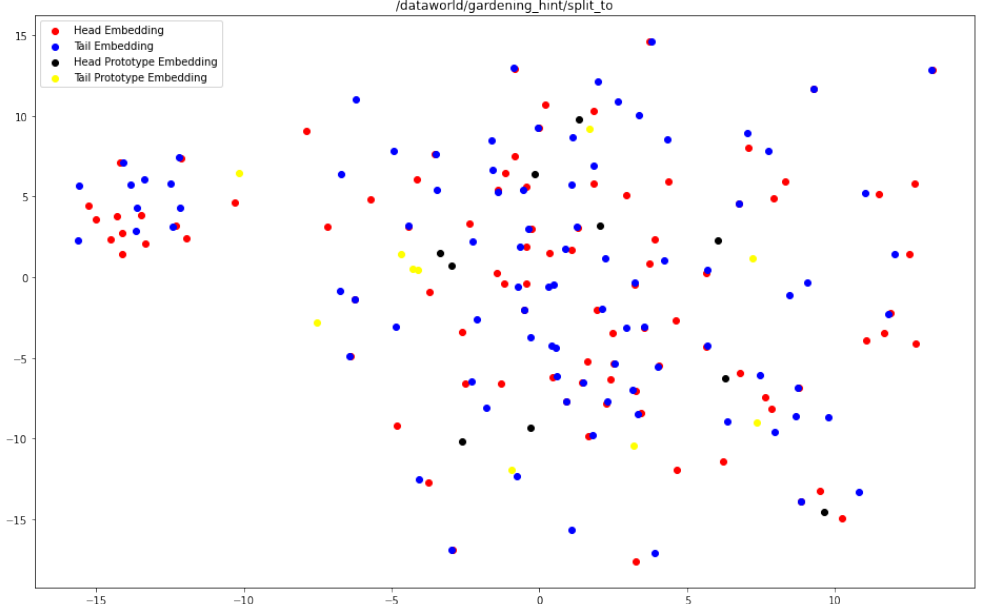
Figure A4. A total of 93 different head entities, 90 different tail entities, and 99 records in the training data. Some of the head entities and tail entities overlap because the relation is